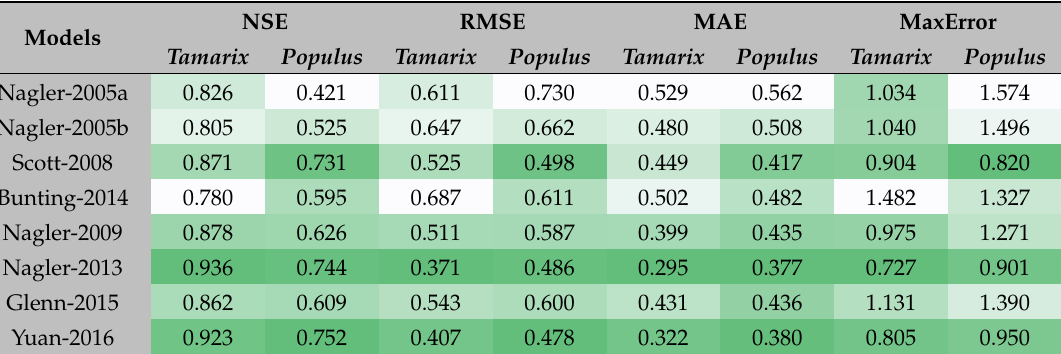
Table 4. Statistical performance of the eight ERSETMs for daily ET throughout the 2017 growing season of the Tamarix site and daily ET throughout the 2016 growing season of the Populus site. The total number of observations was 170 for the Tamarix site and 150 for the Populus site. The NSE is unitless. The RMSE, MAE, and the MaxError are in millimeters per day. The greener the color of the cells, the better the model performs. NSE RMSE MAE MaxError